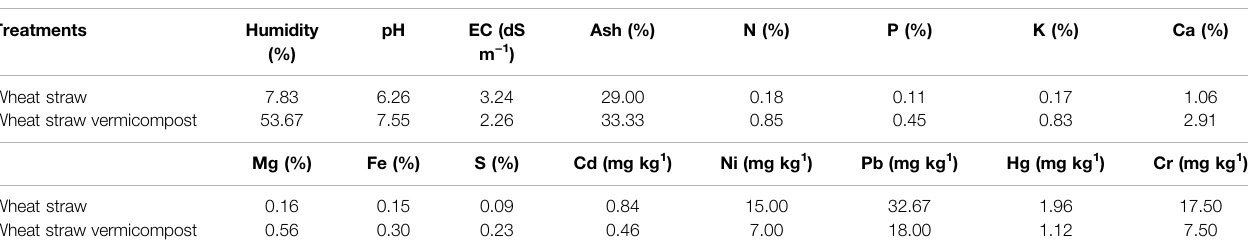
TABLE 1 | Analysis of raw material, vermicompost, and cellulolytic microbe – enriched vermicompost.